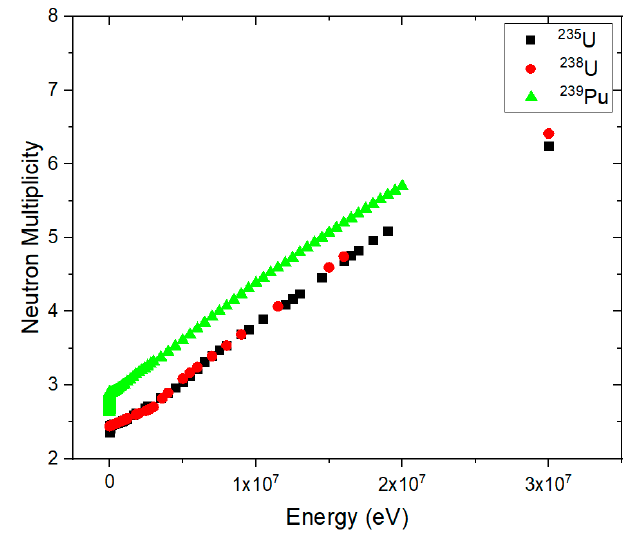
Figure 3. Neutron multiplicity as function of incident neutron energy for 235 U and 239 Pu.